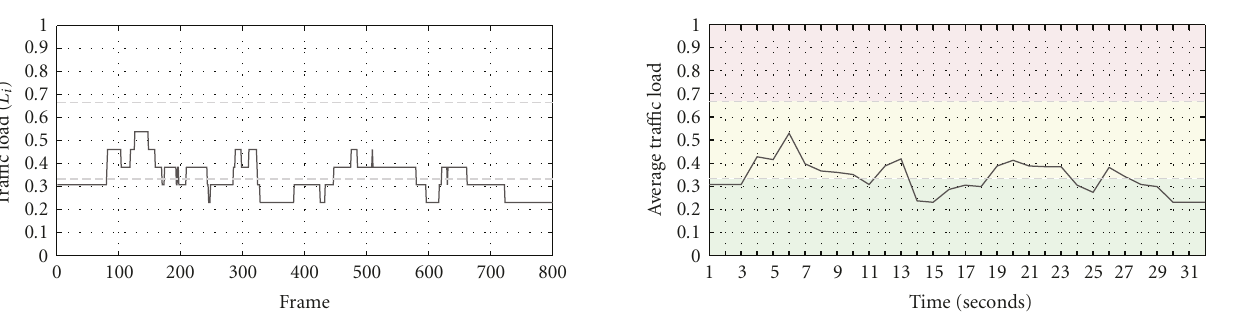
Figure 18: Tra ffi c load L i at every frame in a real sequence.